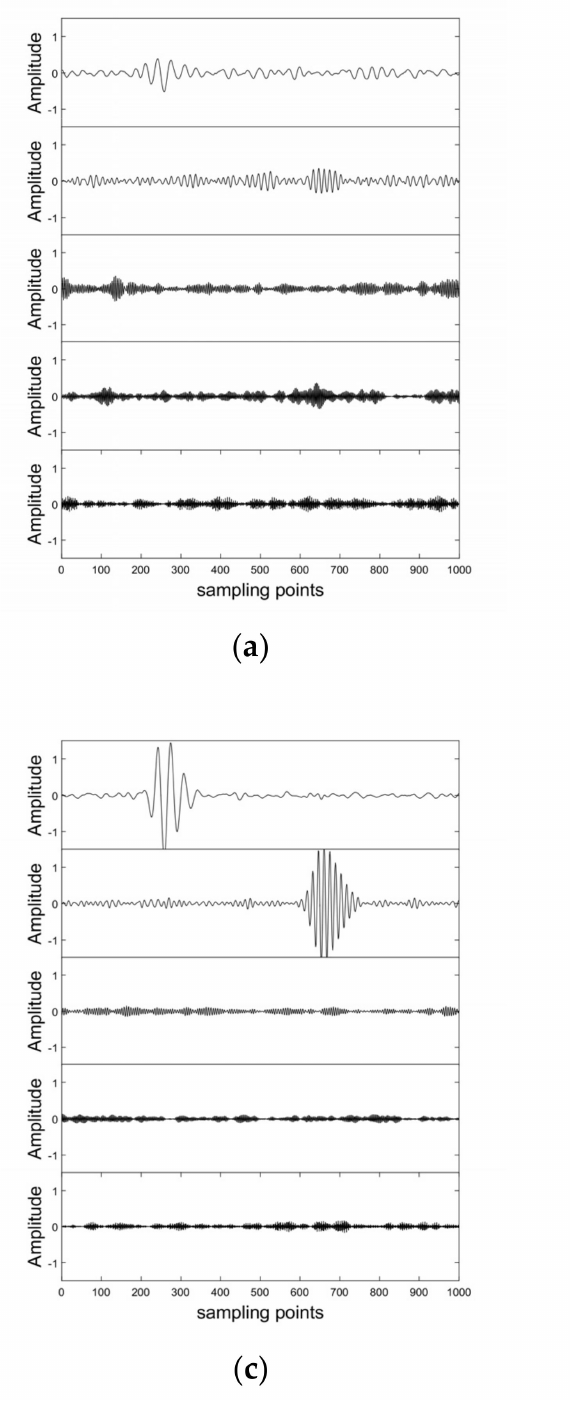
Figure 4. The IMFs of VMD for the synthetic three-component data. ( a ) The VMD result of the H1 component. ( b ) The VMD result of the H2 component. ( c ) The VMD result of the vertical